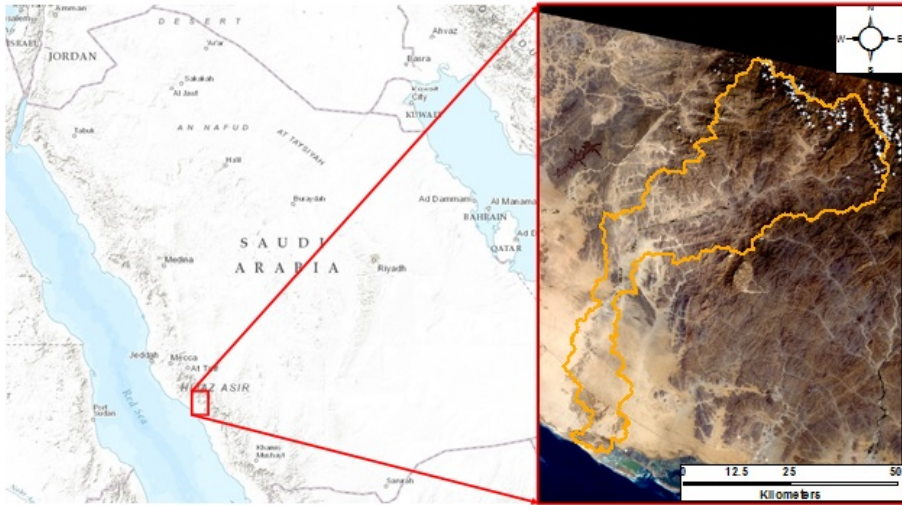
Figure 1. Location of Wadi Yalamlam (Bahrawi et al.,